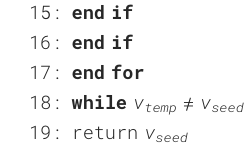
Algorithm 2. Seed selection.